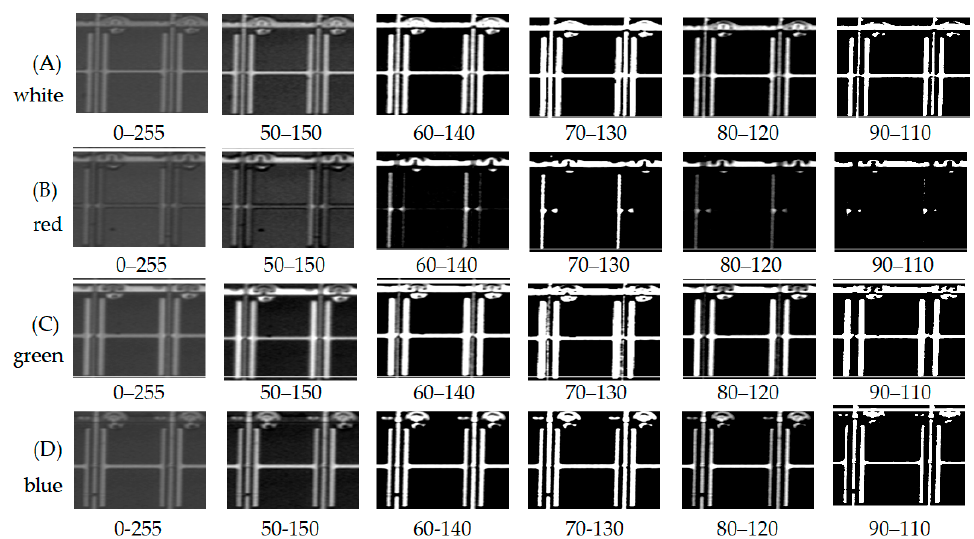
Figure 3. Recognition of the metal electrode on the third layer using white, red, green, and blue LEDs concerning rows ( A – D ) at various gray distribution, which is ( A ) white light, ( B ) red light, ( C ) green light, and ( D ) blue light.